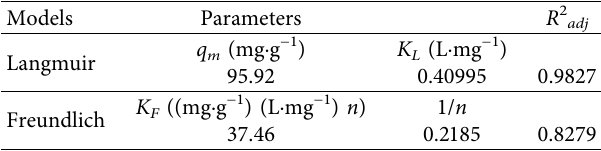
Table 2: Chromium (VI) adsorption isotherm fitting parameters for chromium (VI) by Cu (I)-MOF in aqueous solution.